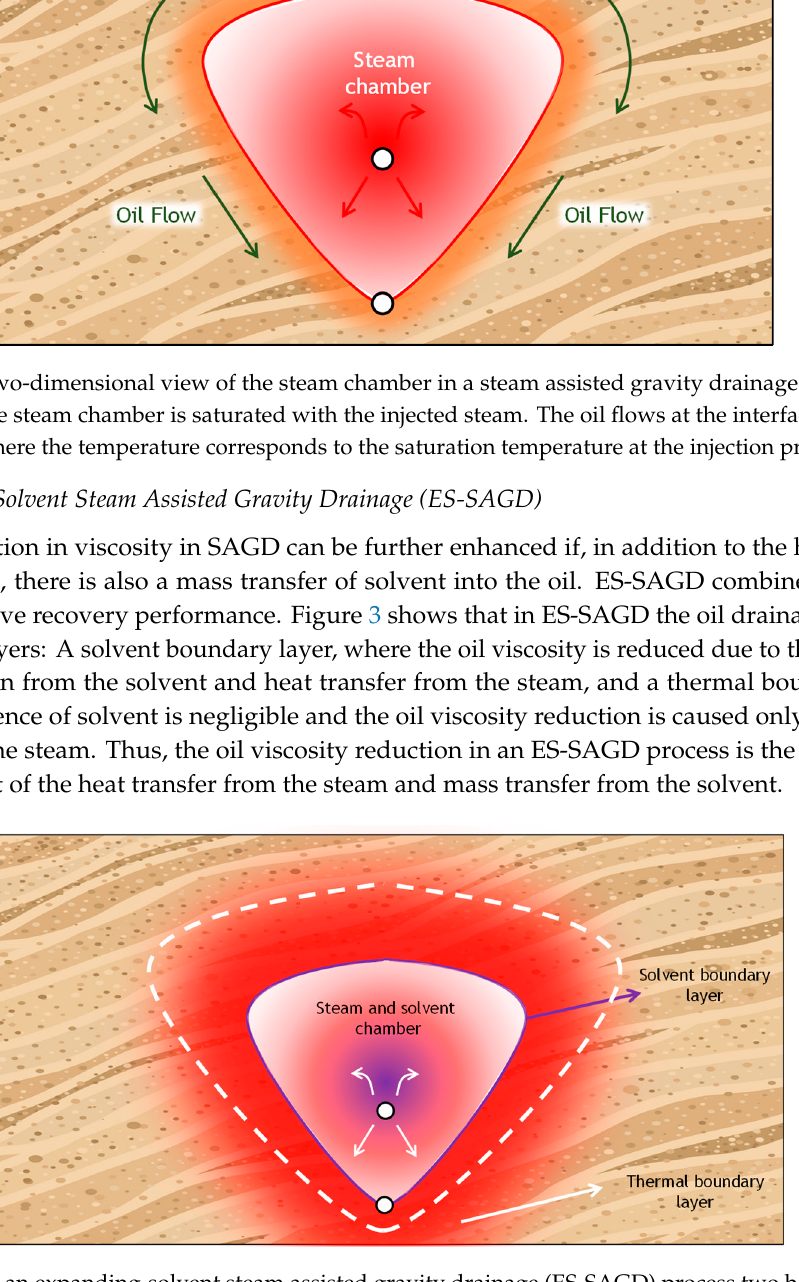
Figure 3. In an expanding-solvent steam assisted gravity drainage (ES-SAGD) process two boundary layers are identified: A solvent boundary layer, that is formed by the combined effect of the steam and solvent injected, and a thermal boundary layer that separates the region of the reservoir that is affected by the heat transfer and the region that is still at the initial temperature.